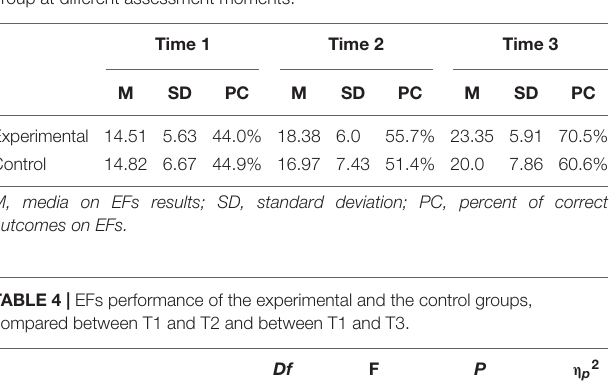
TABLE 3 | Medias, standard deviations, and percent correct outcomes of each group at different assessment moments.